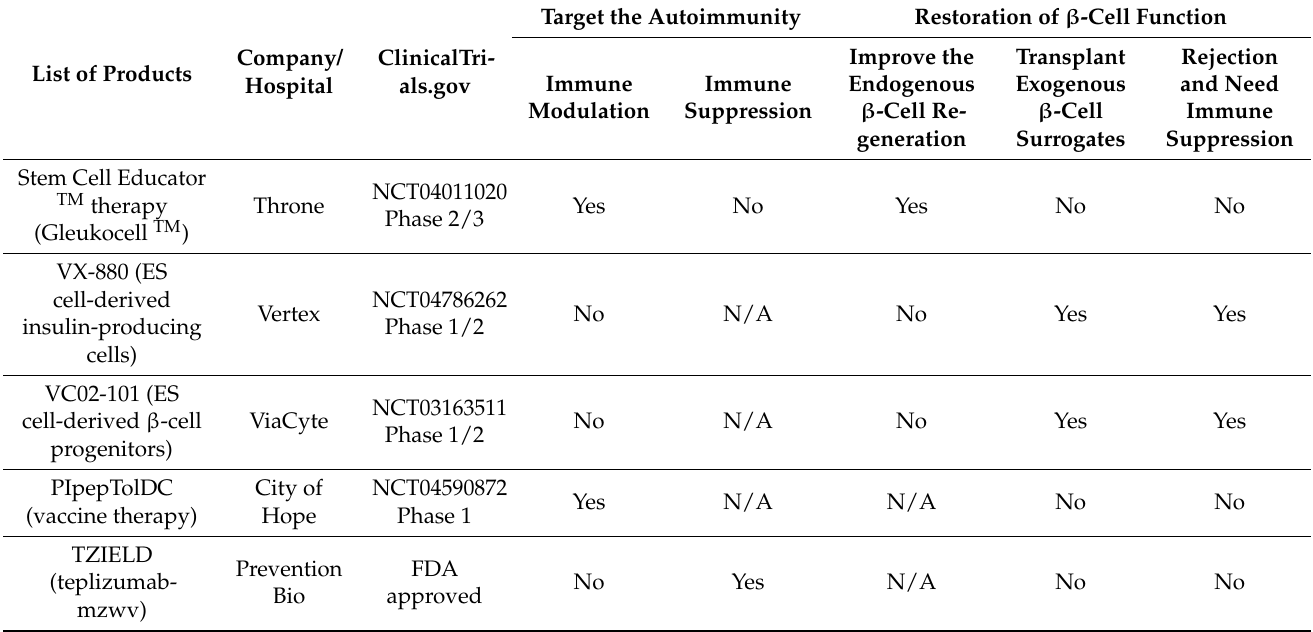
Table 1. Compare the Stem Cell Educator TM therapy with other ongoing clinical therapies/trials in